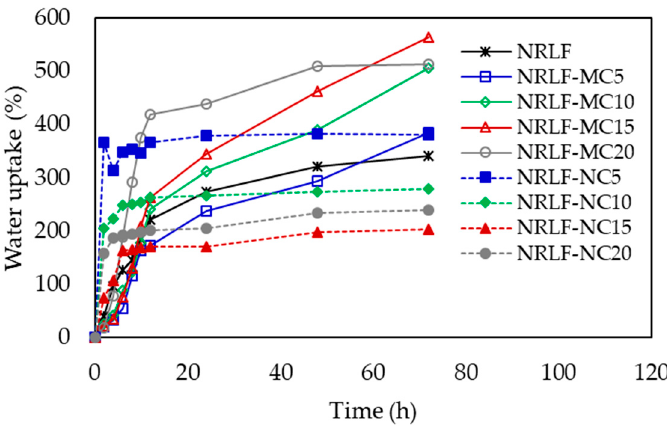
Figure 9. Water uptakes of NRLF, NRLF-MC and NRLF-NC.